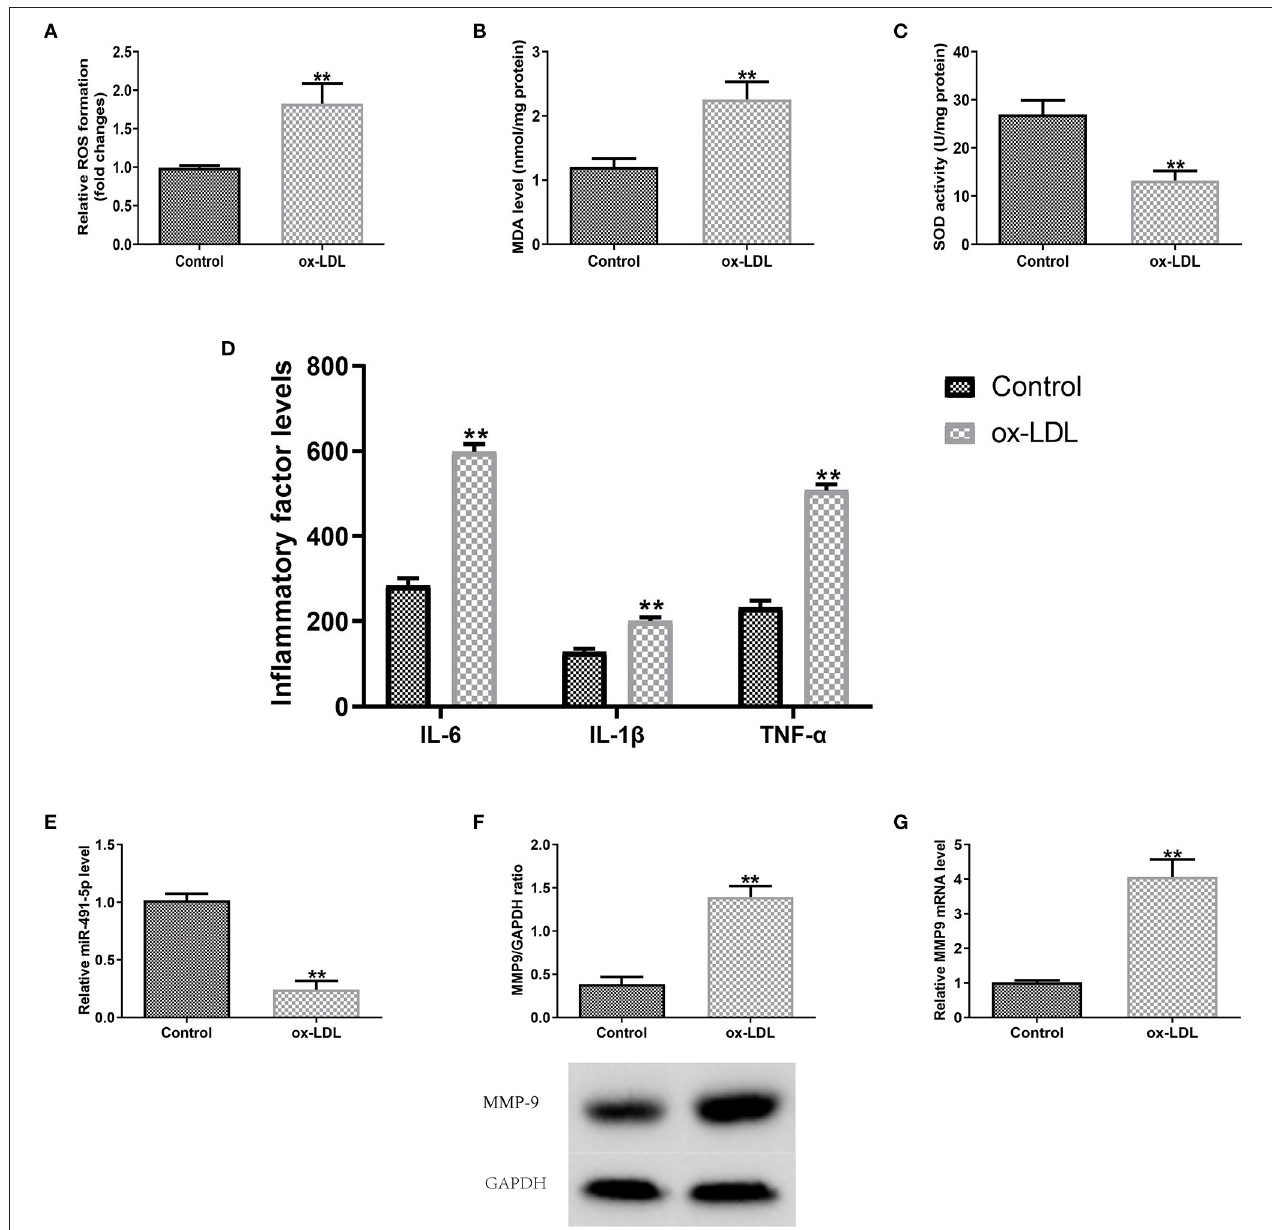
FIGURE 2 | Outcomes of ox-LDL on macrophage expression levels (miR-491-5P and MMP-9), oxidative stress and inflammatory factors. (A–C) ROS and MDA levels and SOD activity were measured using commercial kits. (D) Levels of inflammatory factors (TNF- α , IL-1 β , and IL-6) were detected via ELISA. (E–G) MiR-491-5P, MMP-9 protein, and mRNA levels were measured with qRT-PCR, respectively. Data are presented as the mean ± SD, n = 6. Compared with the control group, ** P < 0.01.